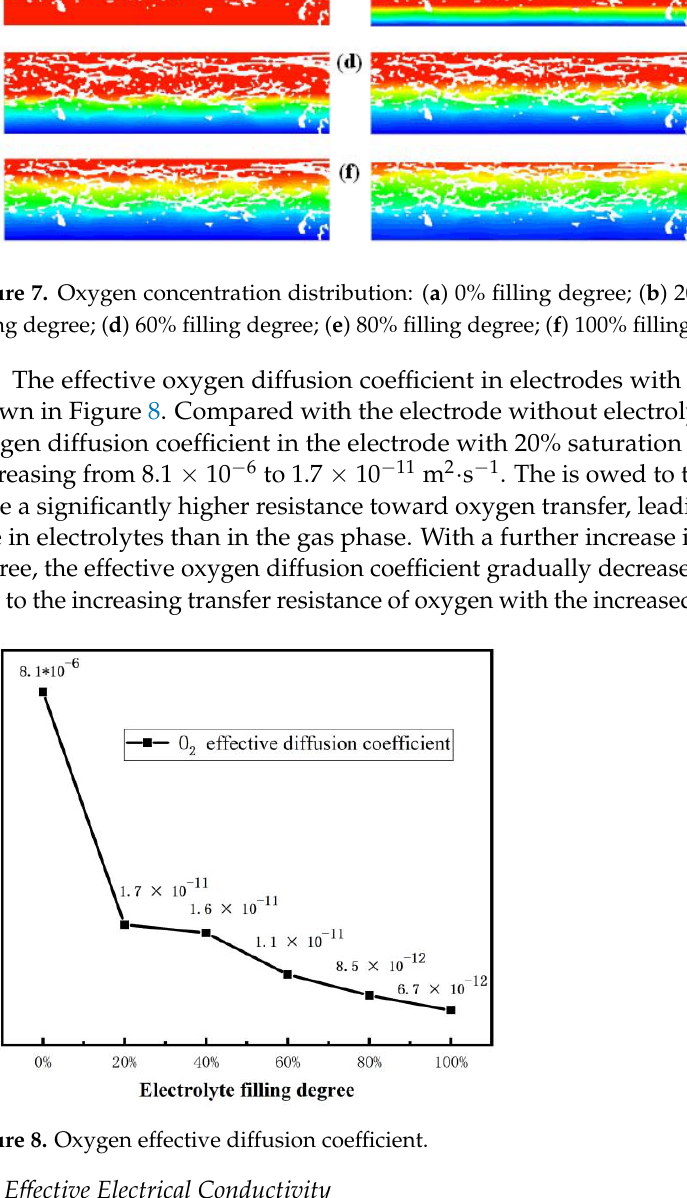
Figure 9. Electric potential distribution: ( a ) 0% filling degree; ( b ) 20% filling degree; ( c ) 40% filling degree; ( d ) 60% filling degree; ( e ) 80% filling degree; ( f ) 100% filling degree. Electrodes with high effective conductivity are conductive to the decrease in ohmic resistance, resulting in superior lithium air battery performance, especially during opera ‐ tion at high current density. Figure 10 shows the effective conductivity of composite elec ‐ trodes with different electrolyte filling degrees. Since oxygen is an insulator, the conduc ‐ tivity is approximate to 0. When the electrolyte filling degree is 0%, it can be inferred that the pores in the composite electrode are filled with oxygen, resulting in the lowest effec ‐ tive conductivity of 56.0 S ∙ m − 1 . With the electrolyte filling degree increasing to 20%, the oxygen at the bottom region of the electrode is occupied by electrolytes. Since the conduc ‐ tivity of the electrolyte is higher than that of oxygen, the overall effective conductivity of the composite electrode increases significantly. The conductivity increases slowly when the electrolyte filling degree ranges from 20% to 80%. The reason for this is mainly due to